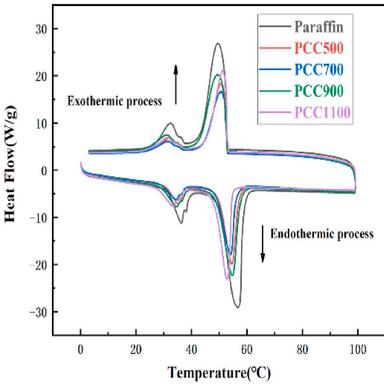
DSC curves of paraffin and PCCs.